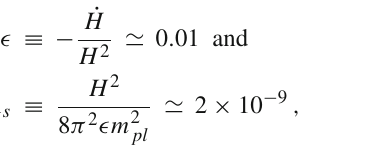
Fig. 5 The e-folds in a 2D parameter scan of μ and F in Plank units (orange), compared with the 60 e-folds’ surface